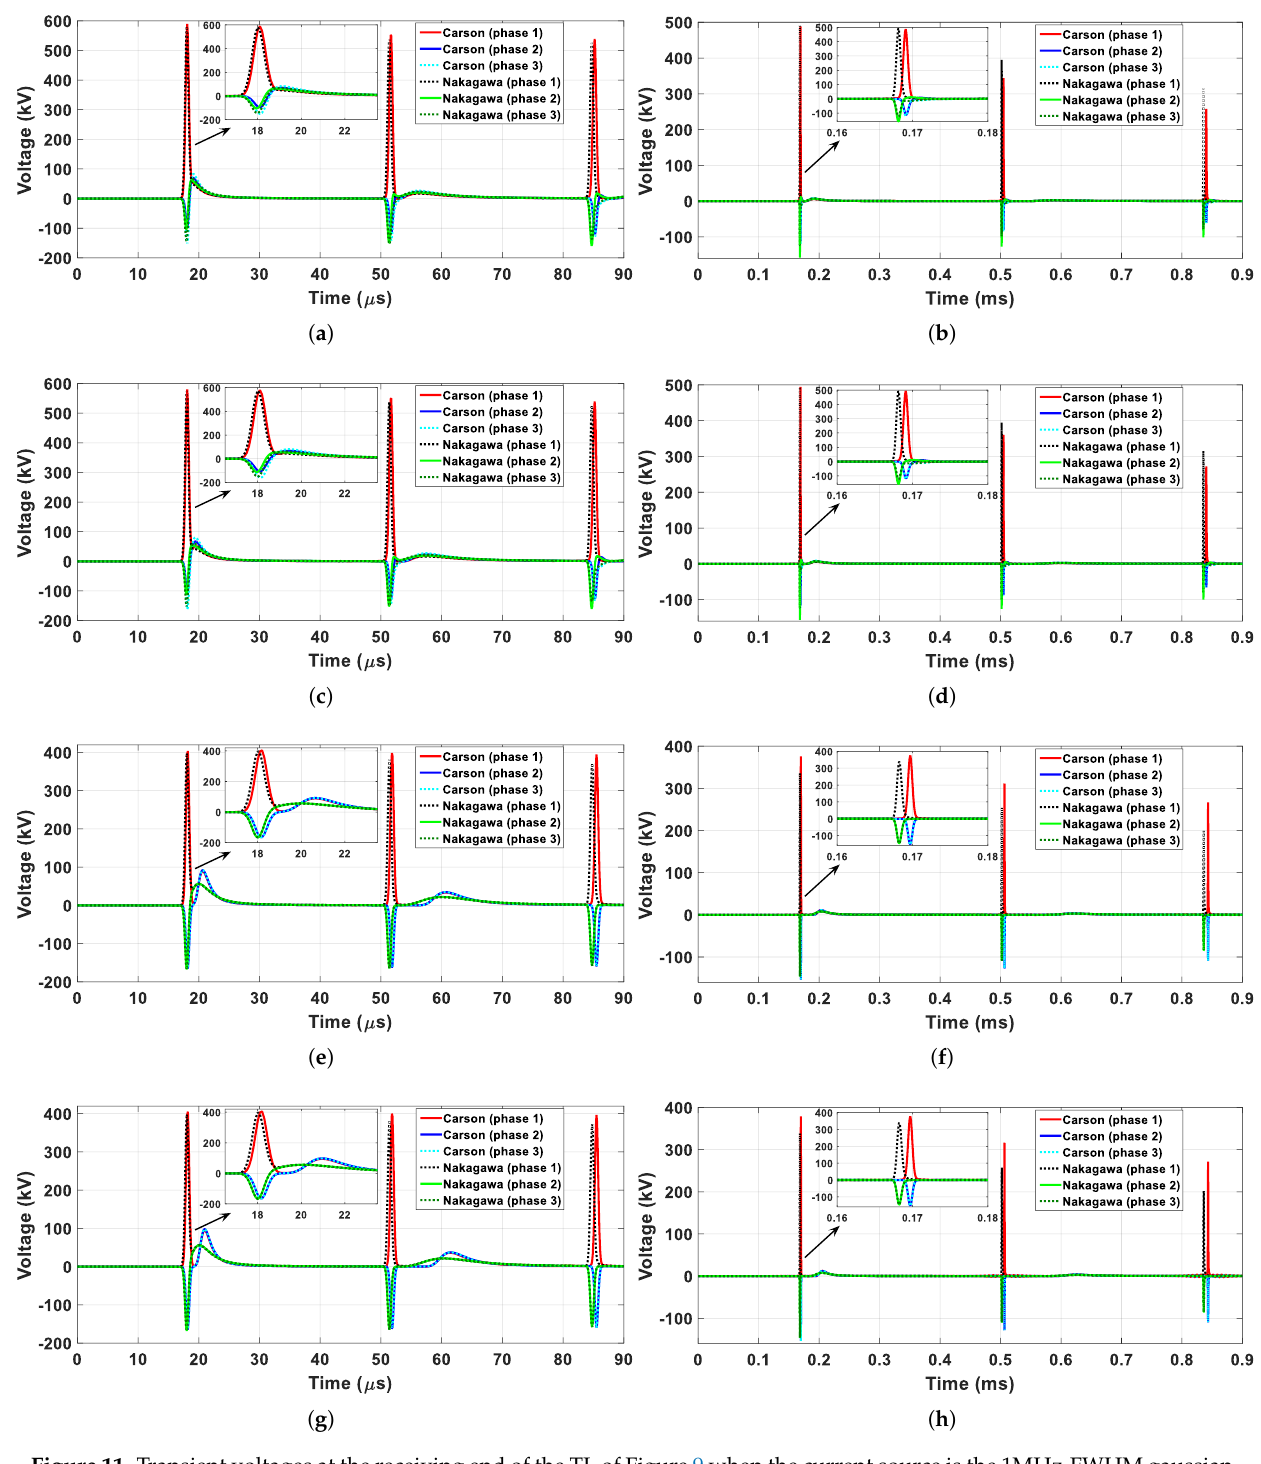
Figure 11. Transient voltages at the receiving end of the TL of Figure 9 when the current source is the 1MHz-FWHM gaussian pulse of Section 4.2, and the length of the line and soil resistivity are, respectively, ( a ) 5 km–500 Ω · m, ( b ) 50 km–500 Ω ·